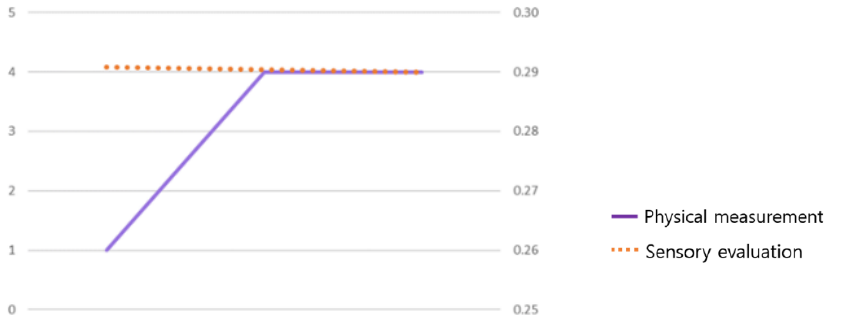
Figure 4. Exemplar comparison of physical measurements and sensory evaluation for a target